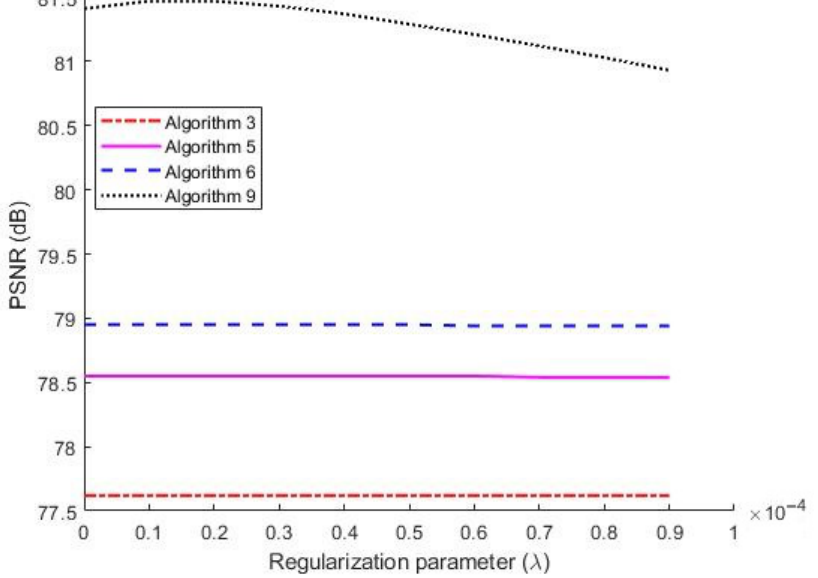
Figure 3. A graph of the PSNR of each algorithm with respect to λ at the 200th iteration.